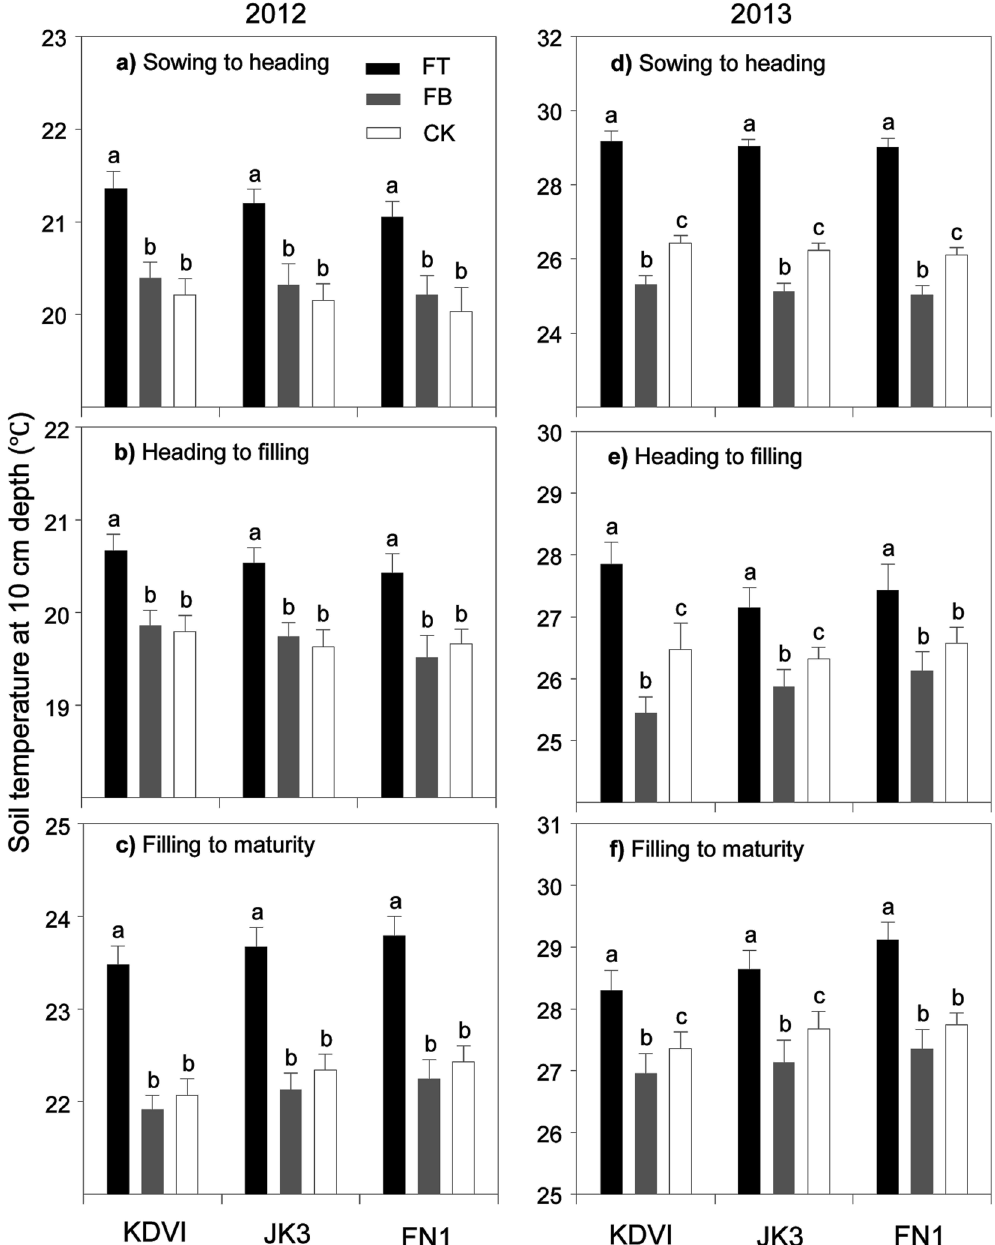
Figure 2. Soil temperature (10 cm soil depth) as affected by maize cultivars (early- mid- and late-maturing, KDVI, JK3 and FN1, respectively) and ridge-furrow differing in mulching materials (FT, alternative ridge- furrow with transparent film mulching; FB, alternative ridge-furrow with black film mulching and CK, alternative ridge-furrow with no mulching) in both growing seasons, on a sandy clay loam in Kenya, east African Plateau. Values followed by the same letters in each cultivar are not significantly different at p < 0.05 level. * , ** and *** significant at p < 0.05, 0.01 and 0.001 level, respectively; ns, not